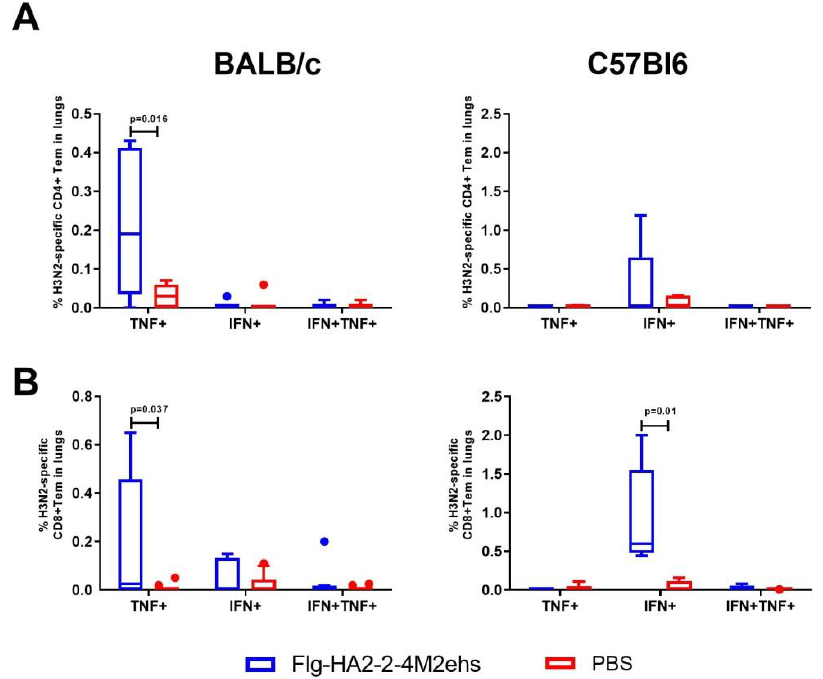
Figure 4. Cytokine profile of H3N2-specific CD4+Tem ( A ), CD8+Tem ( B ) in the lungs of BALB/c and C57Bl6 mice after intranasal immunization with recombinant protein Flg-HA2-2-4M2ehs. The data are presented as Tukey plots. The data of two experiments ( n = 8) were summarized. Significant differences from the control are shown.